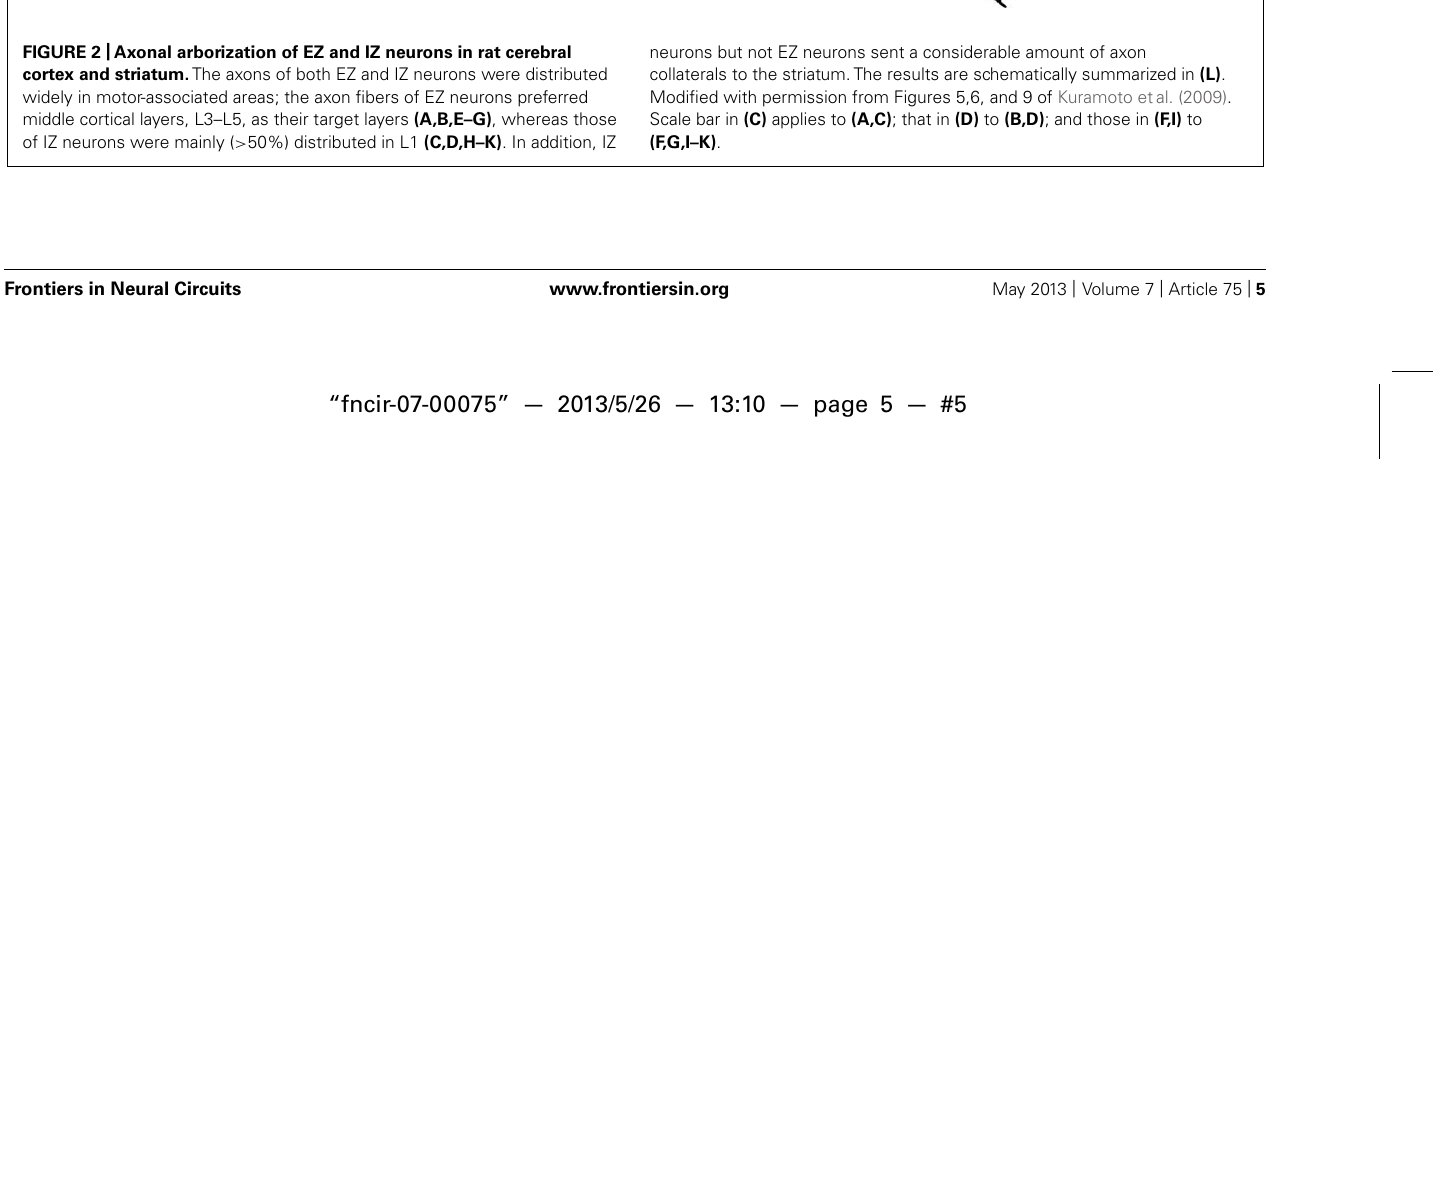
FIGURE 2 |Axonal arborization of EZ and IZ neurons in rat cerebral cortex and striatum. The axons of both EZ and IZ neurons were distributed widely in motor-associated areas; the axon fibers of EZ neurons preferred middle cortical layers, L3–L5, as their target layers (A,B,E–G) , whereas those of IZ neurons were mainly ( > 50%) distributed in L1 (C,D,H–K) . In addition, IZ